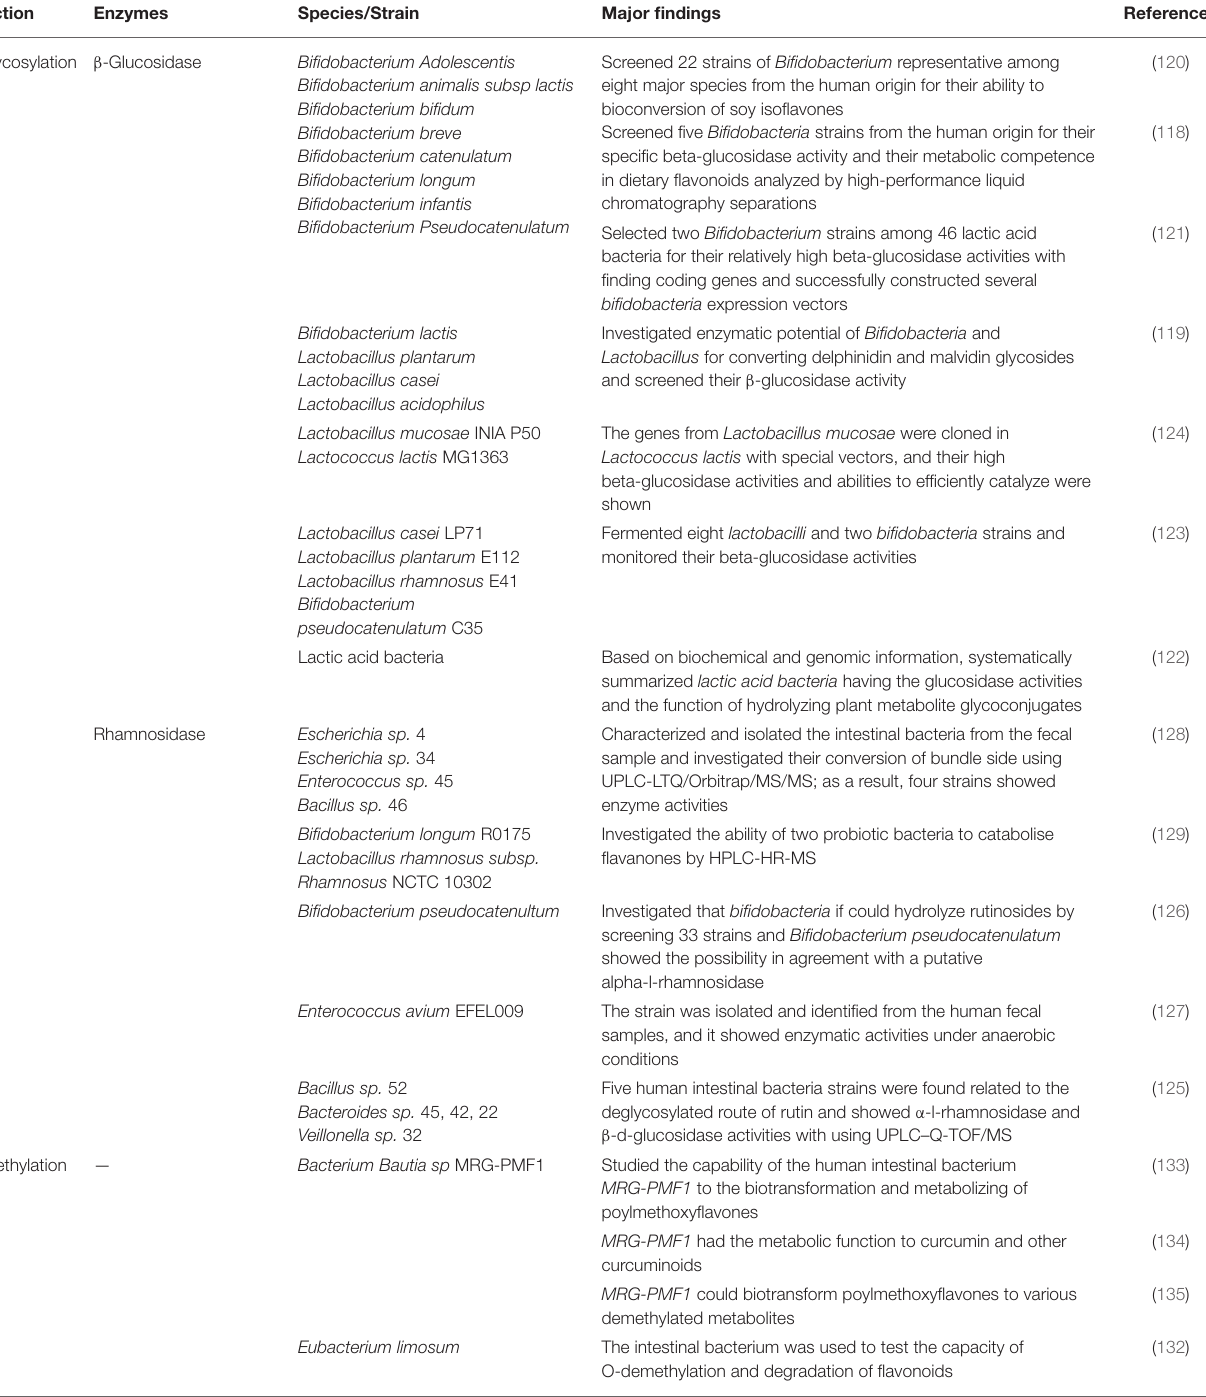
TABLE 2 | Enzymes and microorganisms involved in the transformation of flavonoids by human gut bacteria.